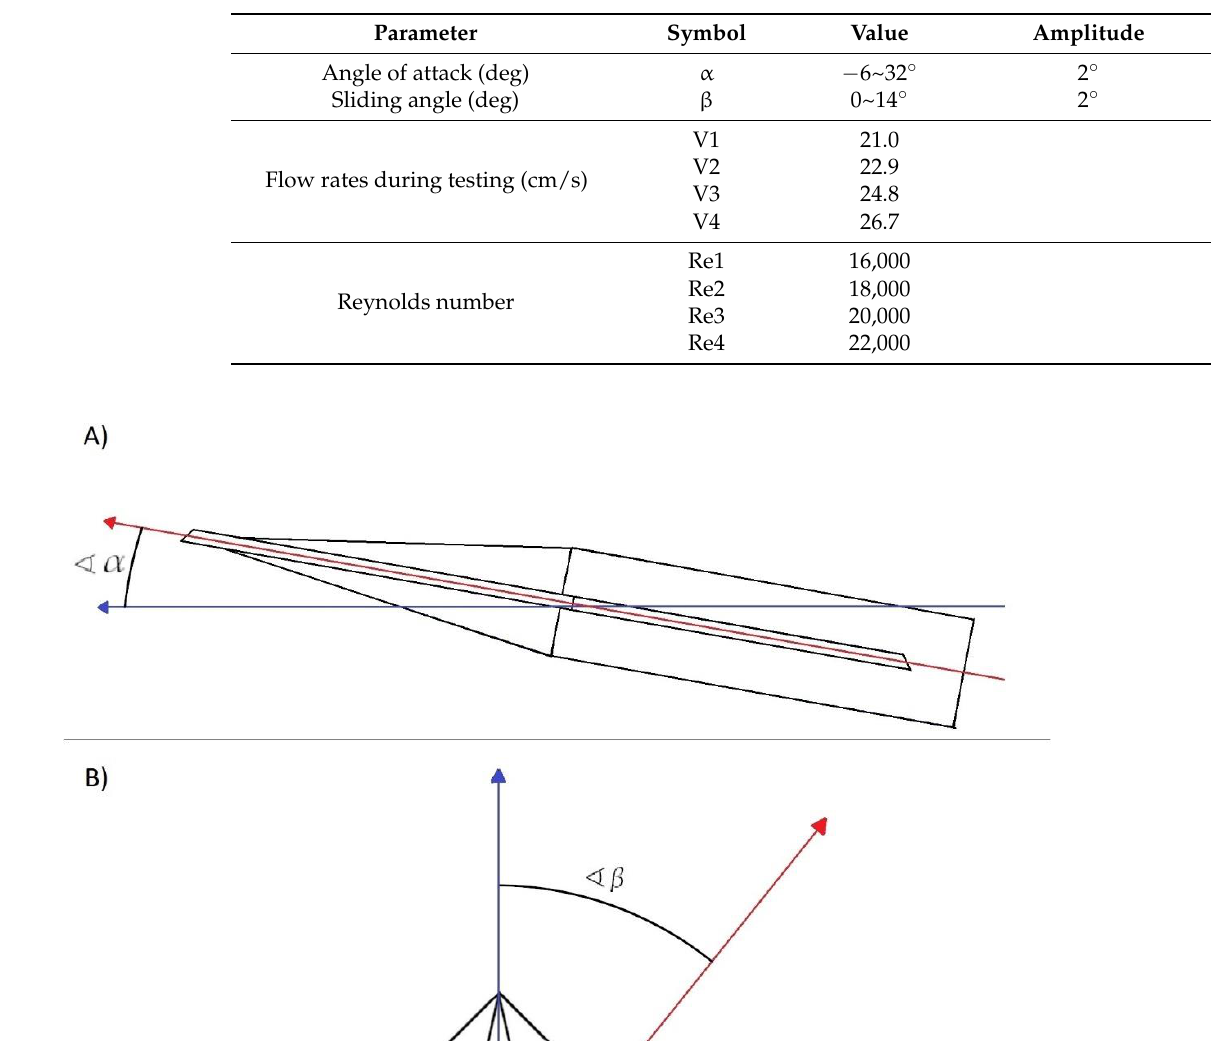
Table 1. The 2D-Sweep static test parameters.